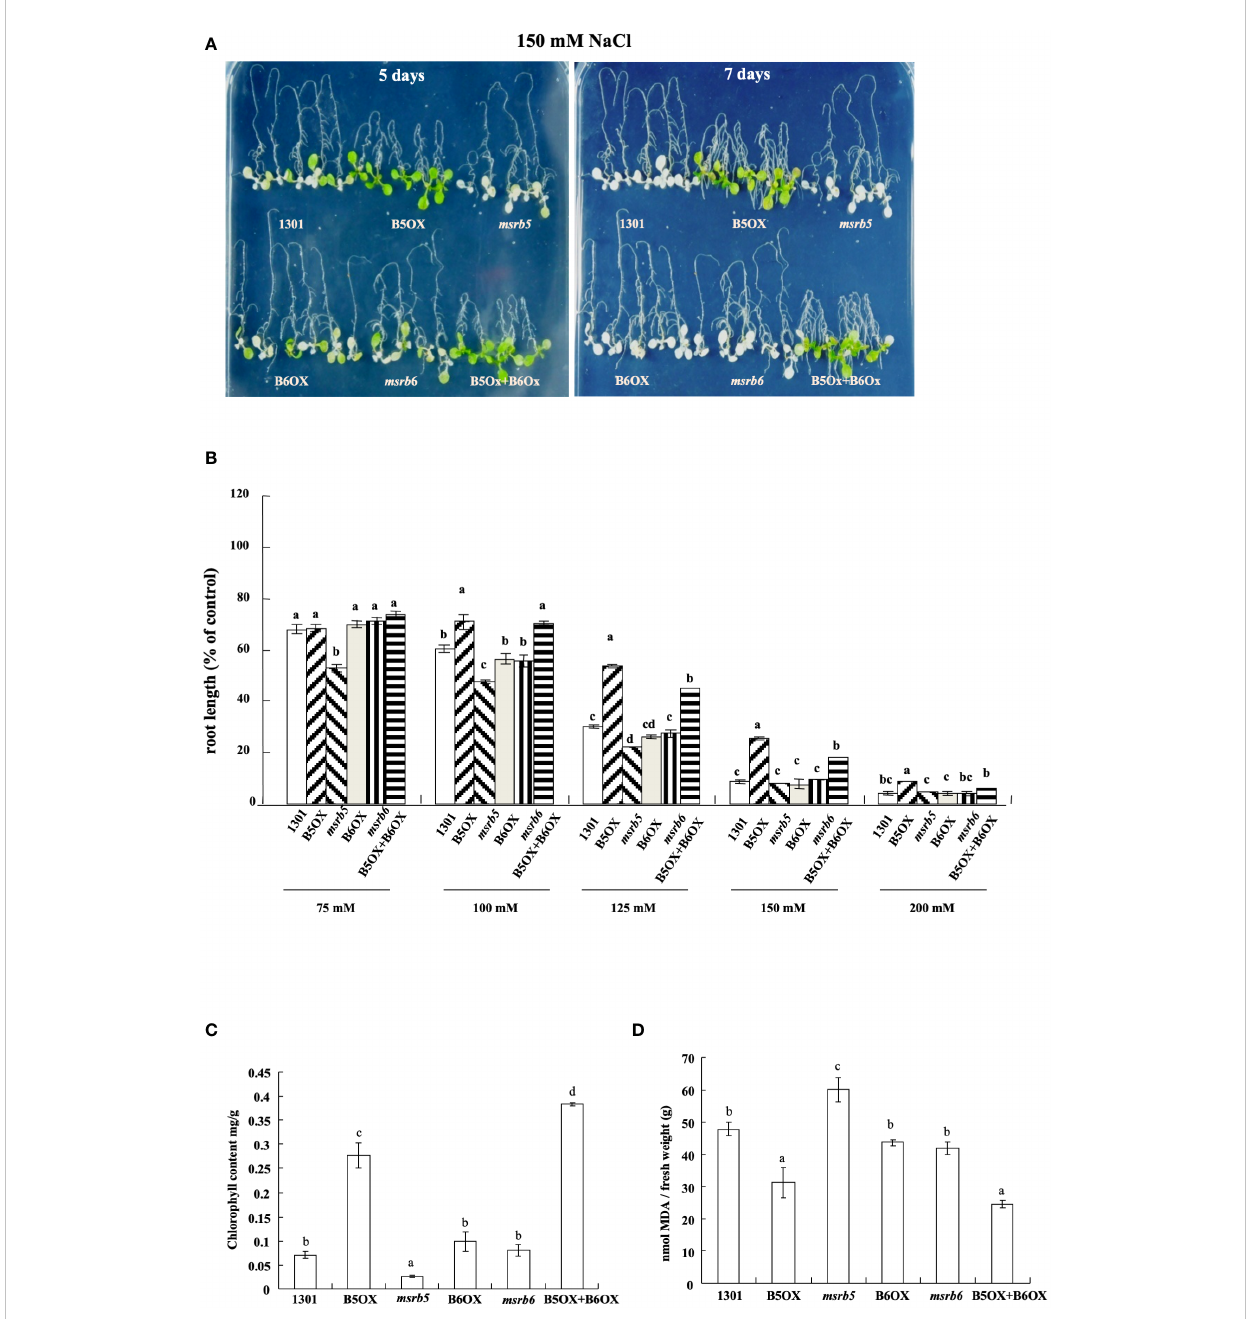
FIGURE 3 AtMSRB5 is involved in salt stress tolerance. (A) Survival phenotype of plants after salt treatment. Seven-day-old Arabidopsis plants were treated with 150 mM NaCl for 5 or 7 days, and their survival phenotype was determined. Each construct contained at least two independent lines for stress treatment. (B) Comparison of relative root length growth under different concentrations of salt. Seven-day-old seedlings were subjected to different concentrations of salt treatment, and maintained vertically. The root length growth after 4 days of salt treatment was scored and compared with those grown under control conditions. (C) Chlorophyll and (D) MDA contents of individual lines after salt stress treatment for 7 days. Data are means± SD ( n = 20) of three independent experiments and analyzed statistically using Duncan ’ s test. Values are means ± standard errors from 20 samples for each line in a single experiment that was repeated at least three times with similar results. Different letters above each bar indicate signi fi cant difference (LSD post hoc one- way ANOVA, P <